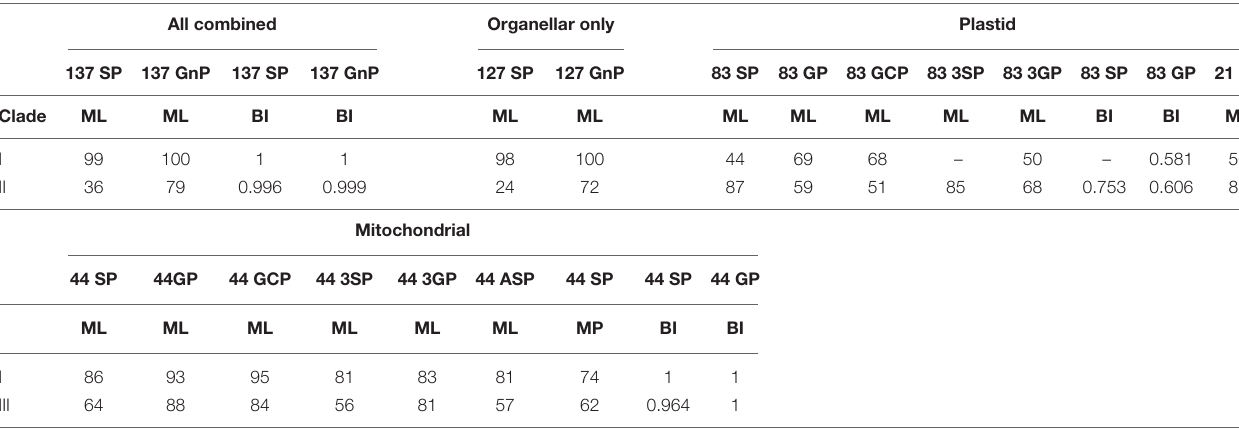
TABLE 2 | Summary of bootstrap and posterior probability support for analyses supporting the two predominantly recovered topologies within perianth-bearing Piperales. All combined Organellar only